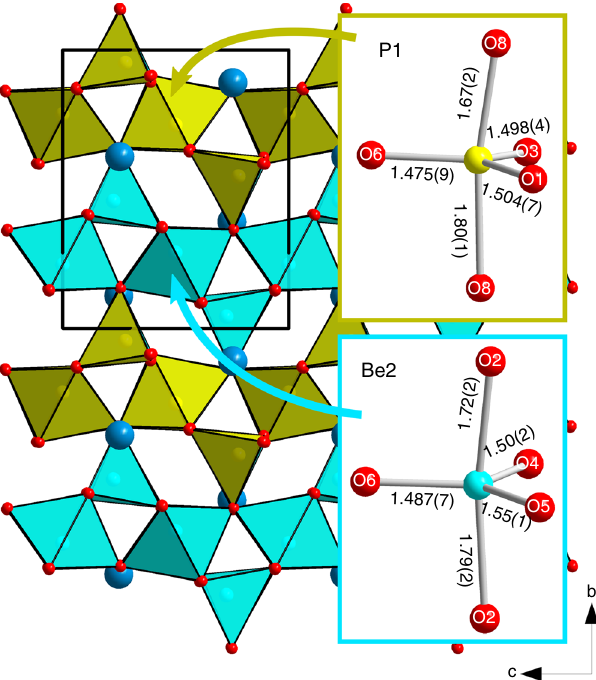
Fig. 3 Crystal structure of hurlbutite-III, CaP 2 Be 2 O 8 at 83.2 GPa. BeO n and PO n polyhedra are given in blue and yellow. Ca and O atoms are given as blue and red spheres, respectively. Black solid line outlines a unit cell. Insets represent the trigonal bipyramidal geometry of PO 5 and BeO 5 groups